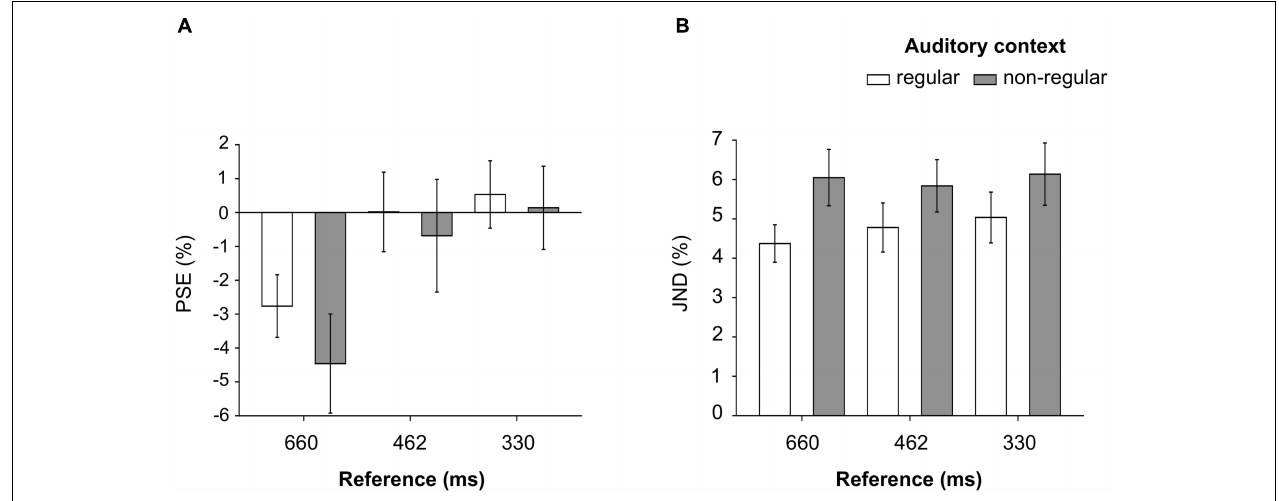
FIGURE 4 | PSE (A) and JND (B) values expressed as a percentage of increase/decrease in the length of the comparison relative to the reference interval (%), measured for the 660 ms, the 462 ms and the 330 ms reference intervals, with regular and non-regular auditory context.